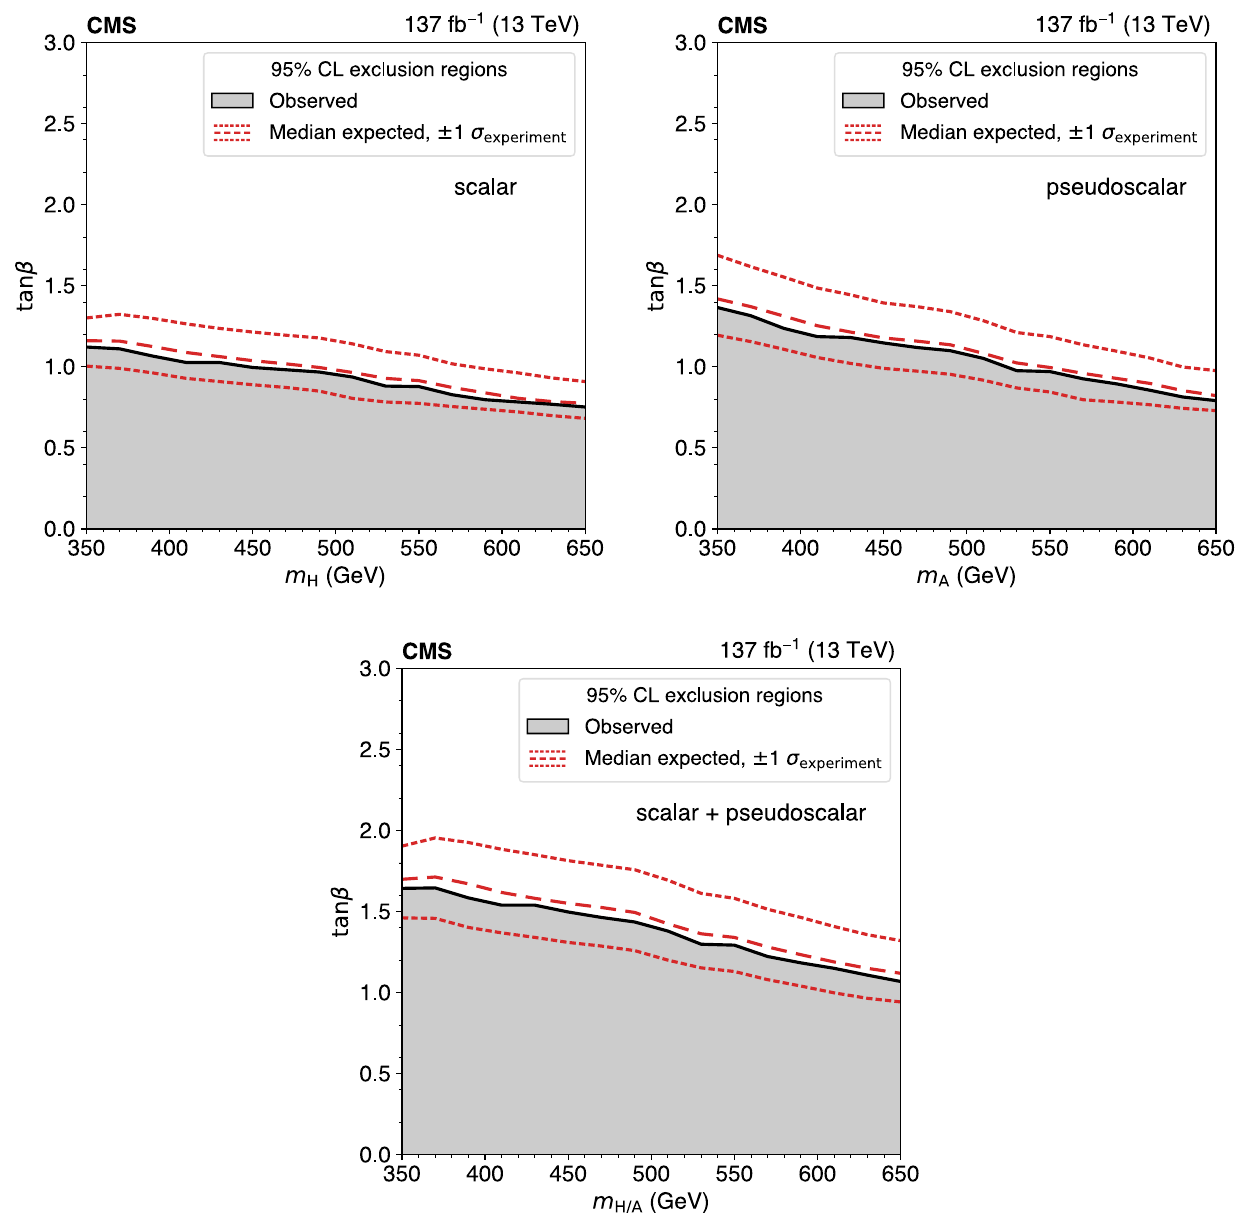
Fig. 8 The observed (solid curve) and expected (long-dashed curve) 95% CL exclusion regions in the tan β versus mass plane for Type-II 2HDM models in the alignment limit for a new scalar H (upper left), pseudoscalar A (upper right), and both (lower) particles. The short-